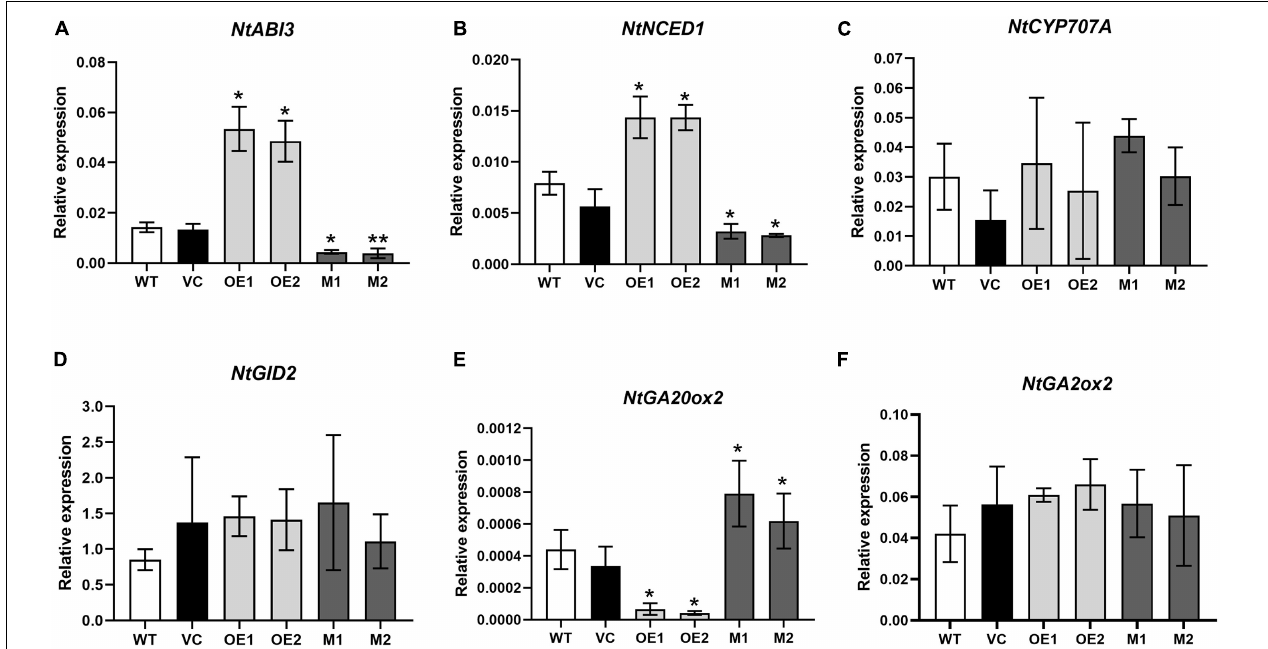
FIGURE 9 | Quantitative analyses of transcript levels of the genes involved in homeostasis and signal transduction of ABA/GA in tobacco seeds. Relative expression levels of (A) NtABI3 (ABA signaling-related gene), (B) NtNCED1 (gene involved in ABA biosynthesis), (C) NtCYP707A (gene involved in ABA catabolism), (D) NtGID2 (GA signaling-related gene), (E) NtGA20ox2 (gene involved in GA biosynthesis), and (F) NtGA2ox2 (gene involved in GA catabolism) in the seeds of WT, VC, NtMYB330-OE lines and ntmyb330 mutant plants. Data are the mean of three replicates with error bars indicating ± SD. Asterisks indicate statistically significant differences from WT according to paired t -test (* P < 0.05; ** P < 0.01).